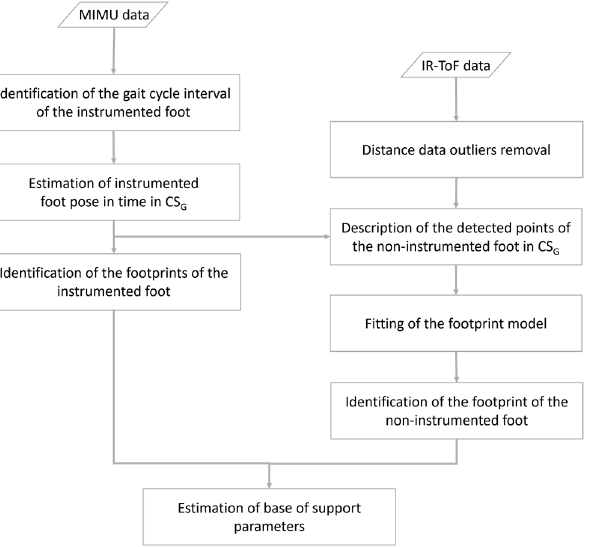
Figure 4. Flowchart of the methods implemented to estimate the base of support parameters from MIMU and infrared time-of- fl ight (IR-ToF) distance data with respect to the global coordinate sys- tem (CS G ).